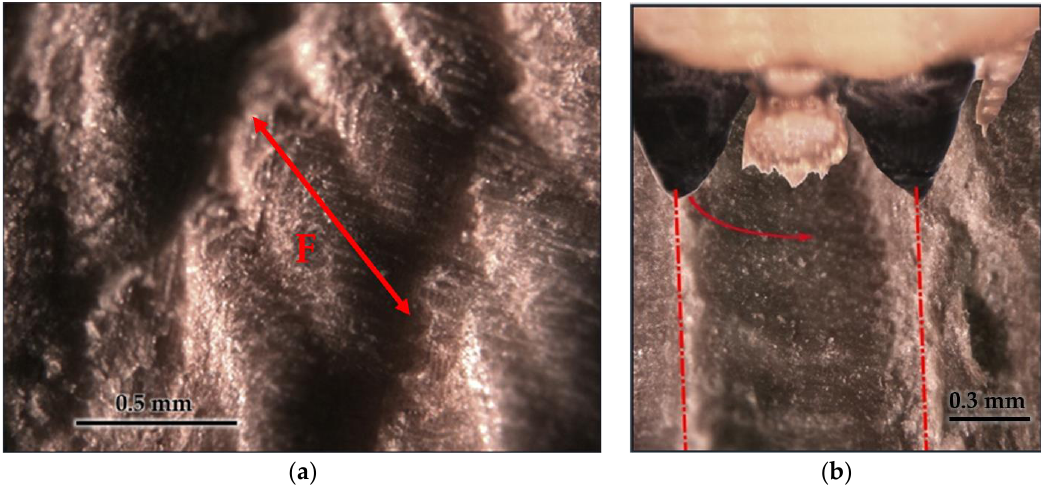
Figure 9. Optical microphotography of the cut footprint ( a ) with shadow play (bite length F = 800 μm) and ( b ) a photographic montage of the larva cutting.